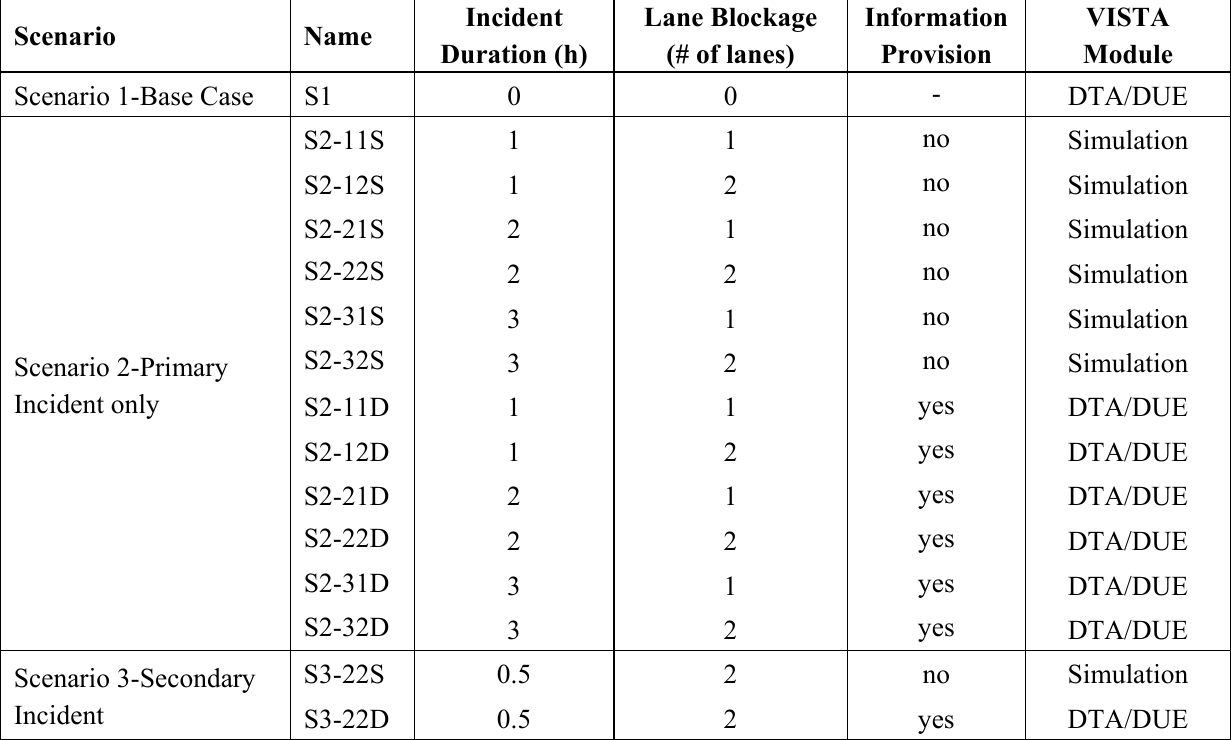
Table 5. Case study